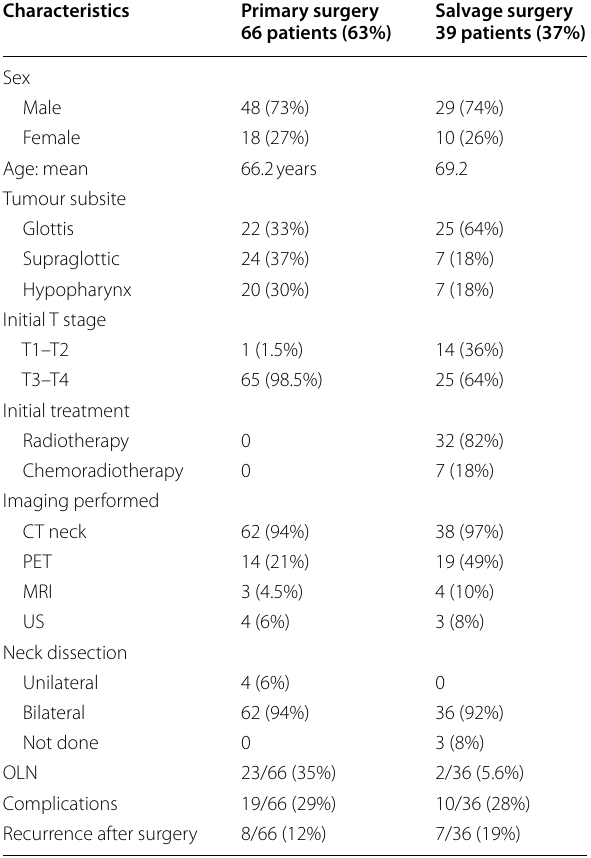
Table 1 Summary of patients’ characteristics included in